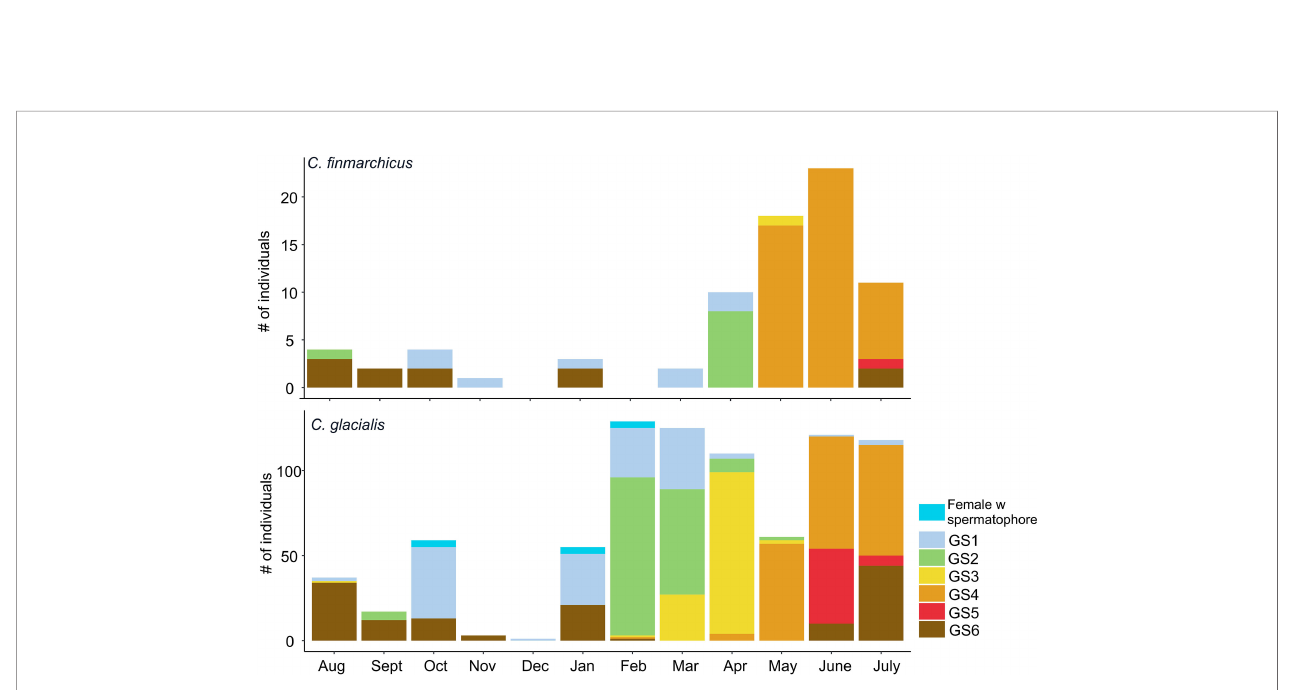
FIGURE 6 | Seasonal changes in gonad maturation of adult females of Calanus in Isfjorden from August 2015 to August 2016. For description of gonadal stages (GS1-GS6) see Table 2